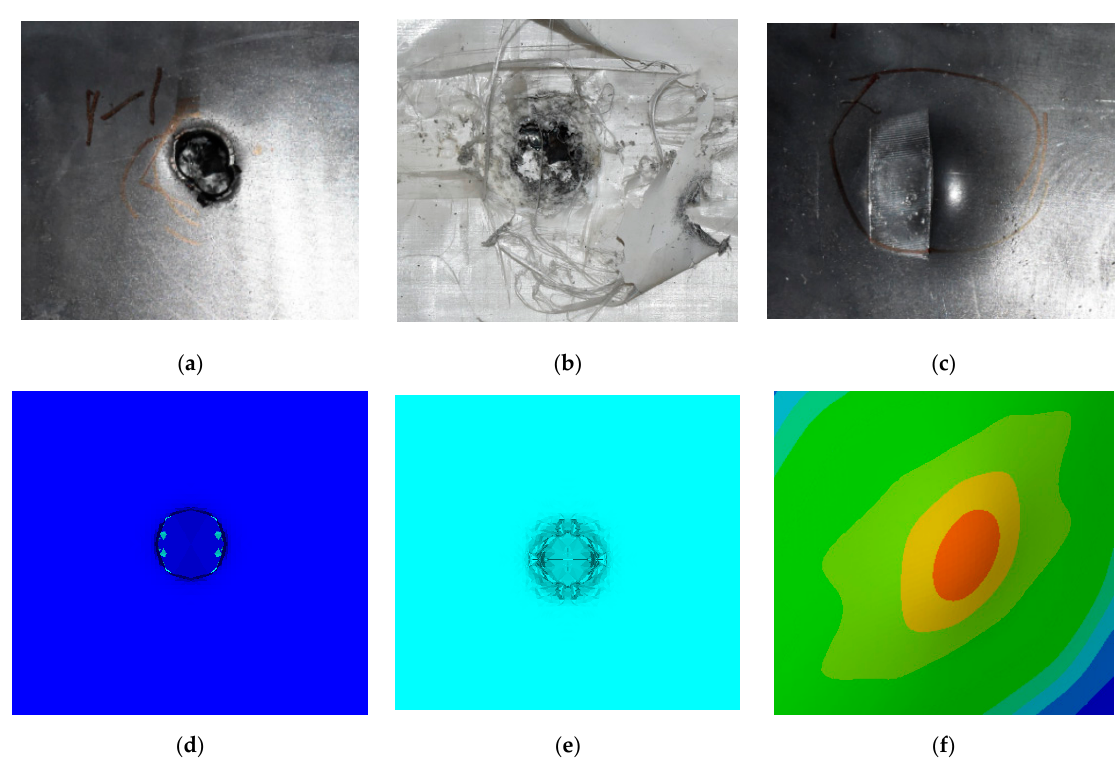
Figure 14. Comparison between the results of the experiment and the numerical simulation at the impact velocity of 759 m/s for composite armor with two layers of PE. ( a ) Face sheet. ( b ) Sub-laminate. ( c ) Deformation on the back sheet. ( d ) Face sheet. ( e ) Sub-laminate. ( f ) Deformation on the back sheet.